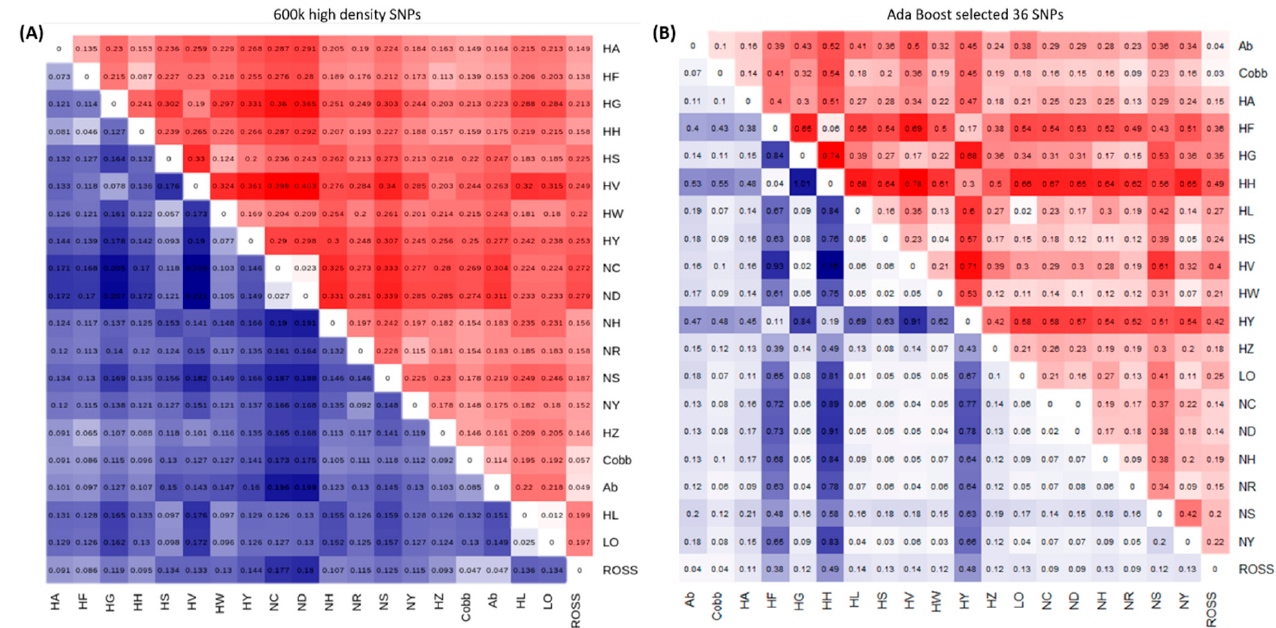
Figure 3. Heatmap showing the genetic distance and fixation index (Fst) results. Genetic distances are shown in blue, and Fst values are shown in red. ( A ) High-density SNPs had reasonable genetic distances and Fst values in their genetic relationships. ( B ) The selected marker combination with 36 SNPs had relatively large genetic distances between the target (case) population and other (control) chicken populations. NC, Rhode Island Red C; ND, Rhode Island Red D; NH, Cornish H; NS, Cornish S; NR, Red Korean native chicken; NY, Yellow Korean native chicken; HH, Hanhyup H; HF, Hanhyup F; HY, Hanhyup Y; HW, Hanhyup W; HS, Hanhyup S; HG, Hanhyup G; HV, Hanhyup V; HA, Hanhyup A; HZ, Hanhyup Z; Ab, Arbor Acre; Cobb, Cobb broiler; Ross, Ross broiler; LO, Lohmann brown; HL, Hyline brown.